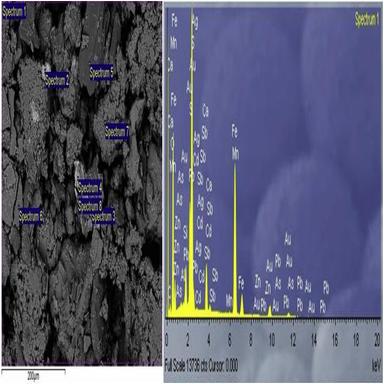
SEM image (a) and the EDS curve (b) of the sample from Gornje Polje Veliko Rudare.